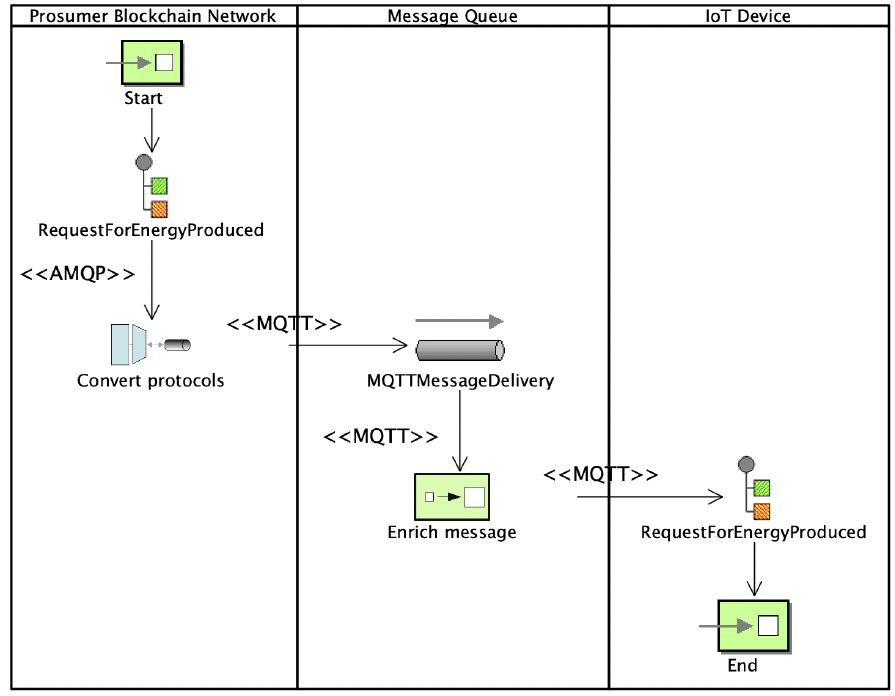
Figure 8. The Send Request for Energy Produced integration